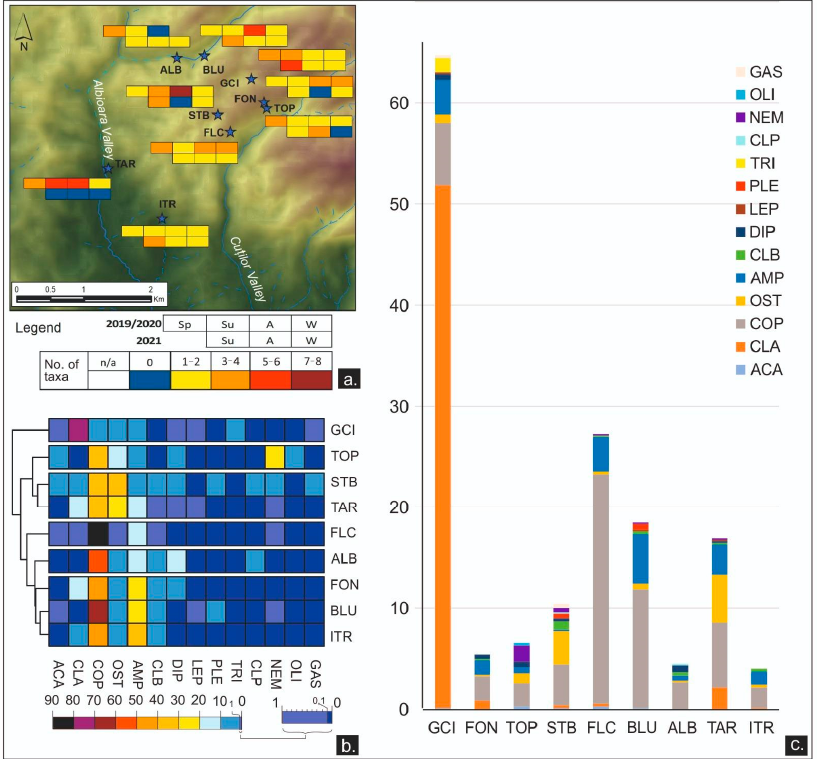
Figure 7. The main groups of meiofauna in the studied freshwater sources from the KSRP: ( a ) The spatial diversity of major taxa (not applicable for ALB-winter-2019, where, due to low temperature leading to frozen stream, the filtering was not feasible); ( b ) Heatmap of the relative abundances and dendrogram clustering of the KSRP freshwater sources. The three-letter acronyms correspond to sampled freshwater sources ALB, BLU, FLC, FON, GCI, ITR, STB, TAR, and TOP (see Table 1), and to meiofauna groups: ACA = Acariformes, AMP = Amphipoda, BAT = Bathynellacea, BIV = Bivalvia, CLA = Cladocera, COL = Coleoptera, COP = Copepoda, DIP = Diptera, GAS = Gastropoda, LEP = Lepidoptera, OLI = Oligochaeta, OST = Ostracoda, PLE = Plecoptera, and TRI = Trichoptera; ( c ) Averages of meiofauna in the sampled water sources of the KSRP.